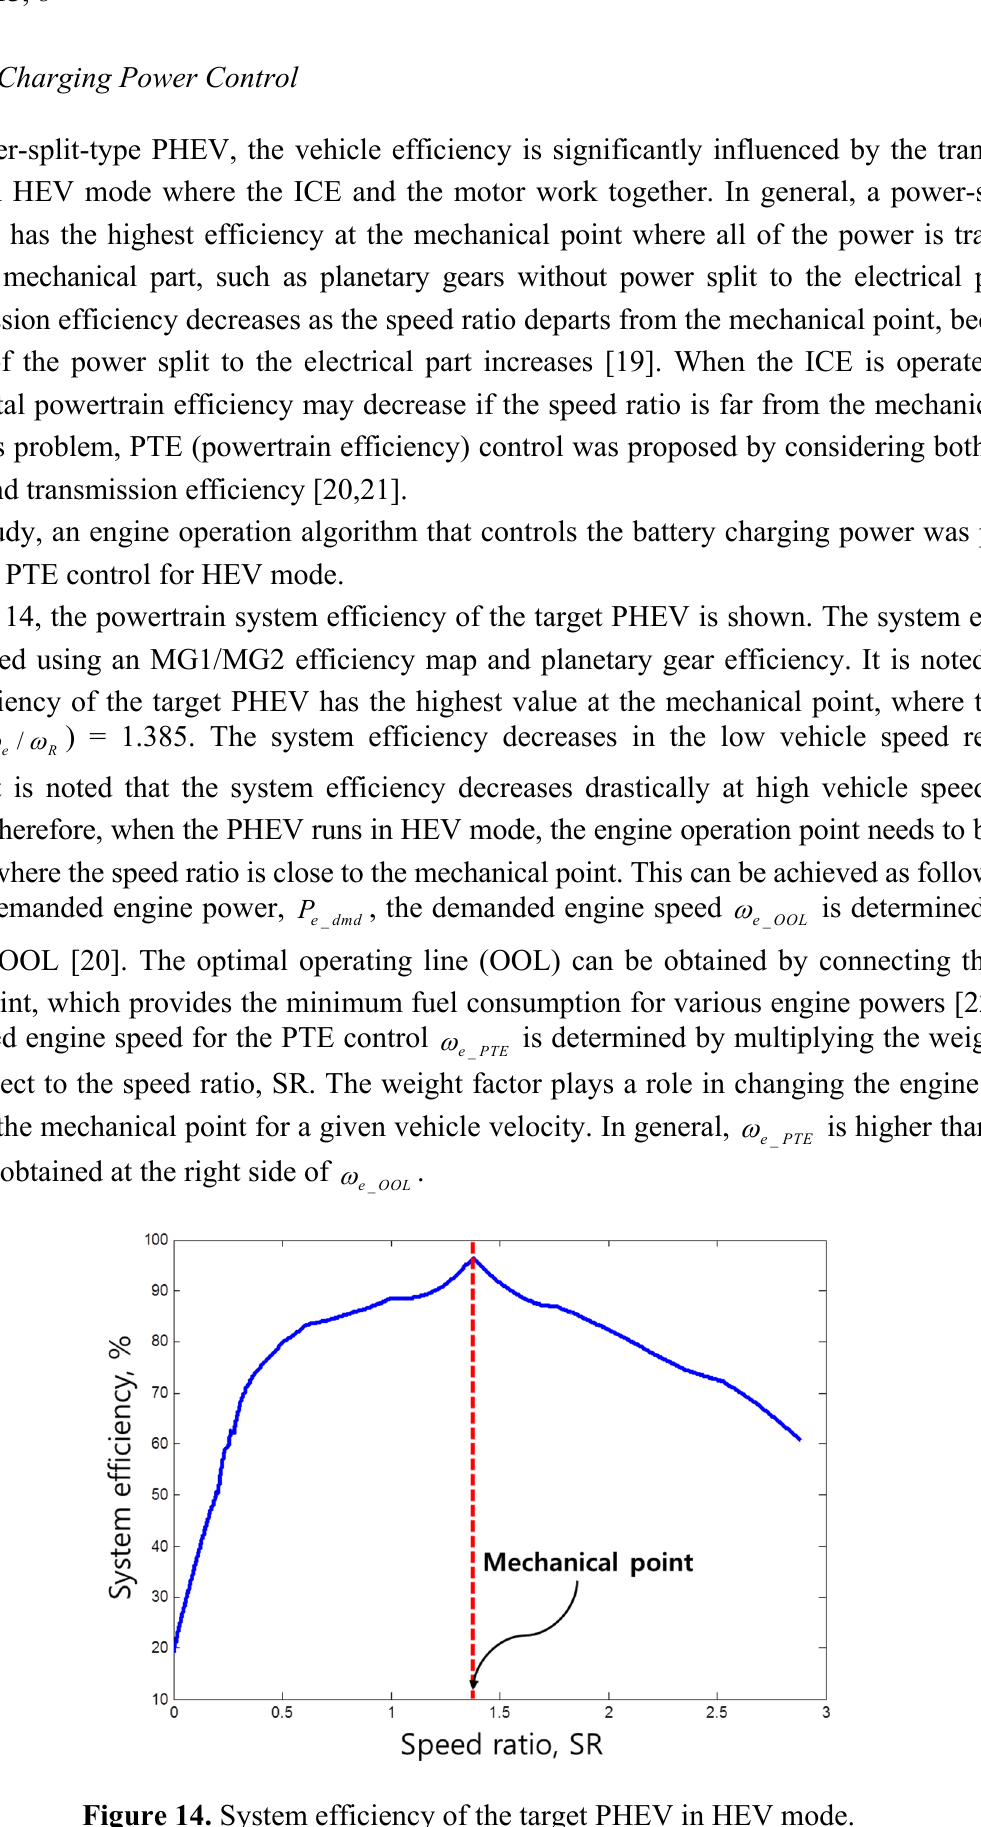
Figure 14. System efficiency of the target PHEV in HEV